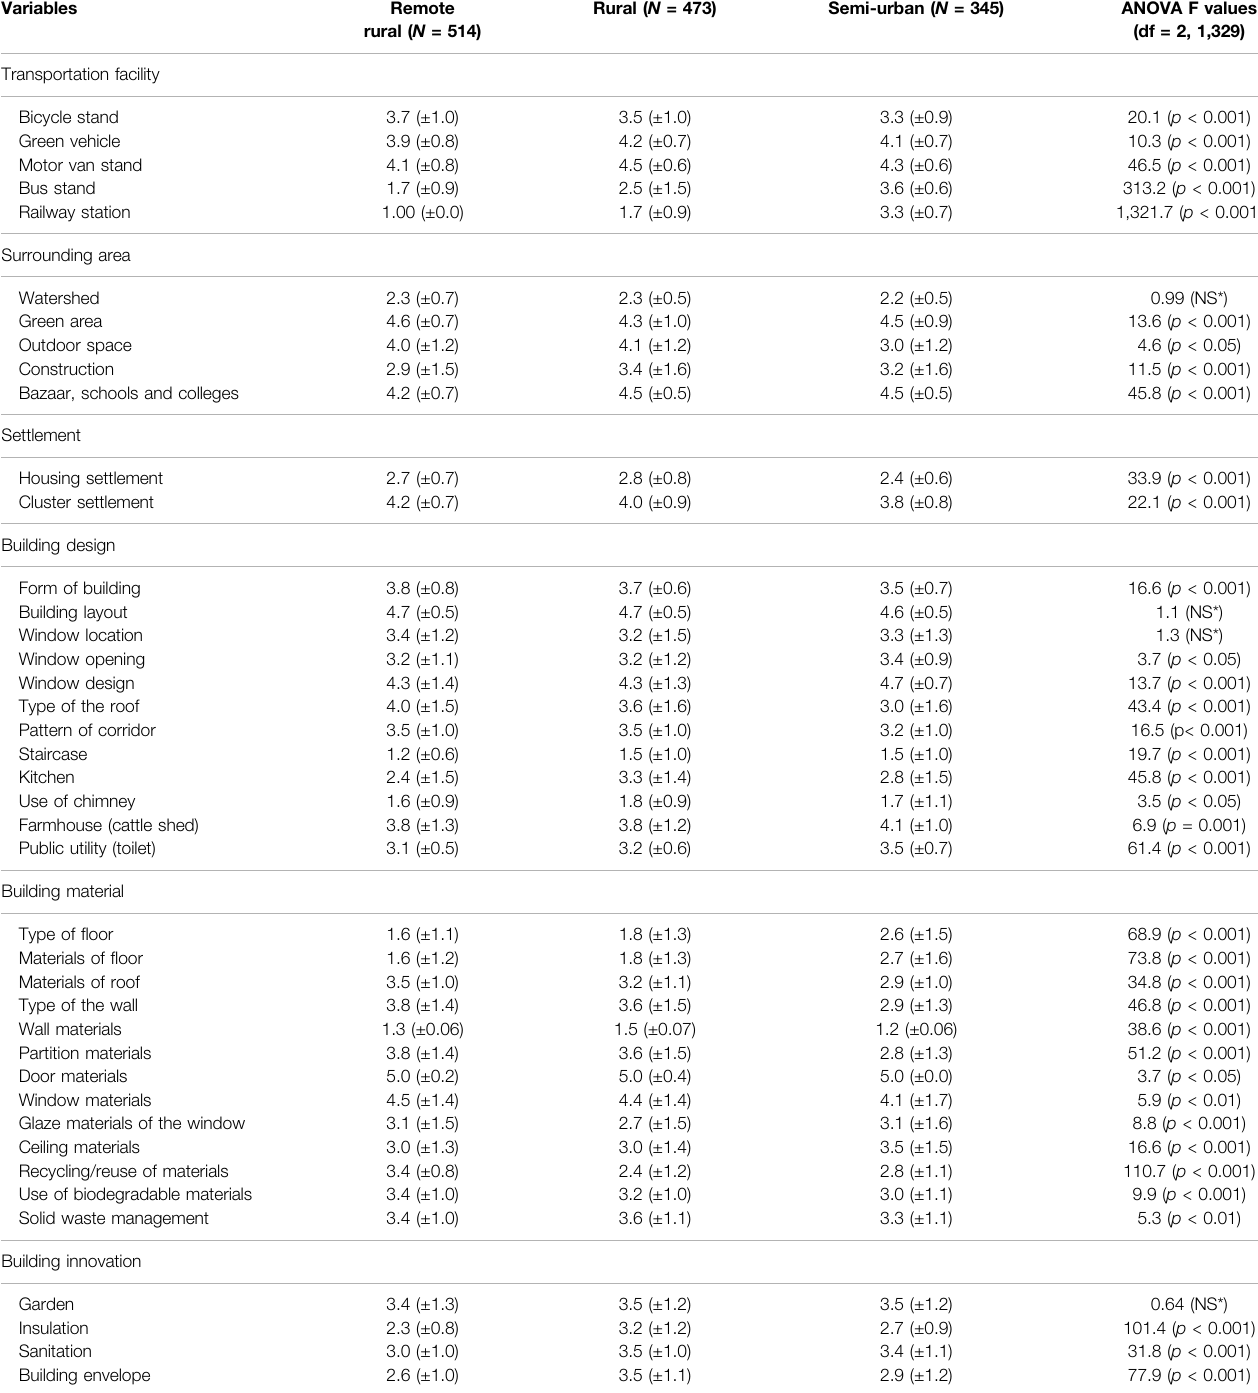
Values (means ± SD) are non-dimensional units of the relative 5-point scale; NS* = not statistically signi fi cant.